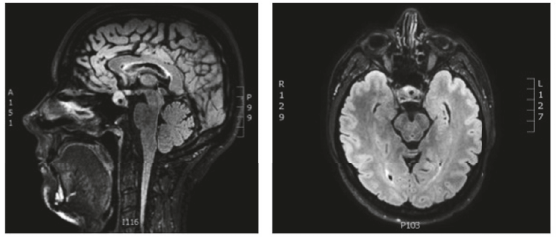
Figure 2: Magnetic resonance imaging of cerebrum. Magnetic resonance imaging (MRI) showed signs of recent bleeding into a cystic adenoma comprising 10x10x8 mm placed in sella turcica with close proximity to the chiasma and displacing the pituitary gland to the